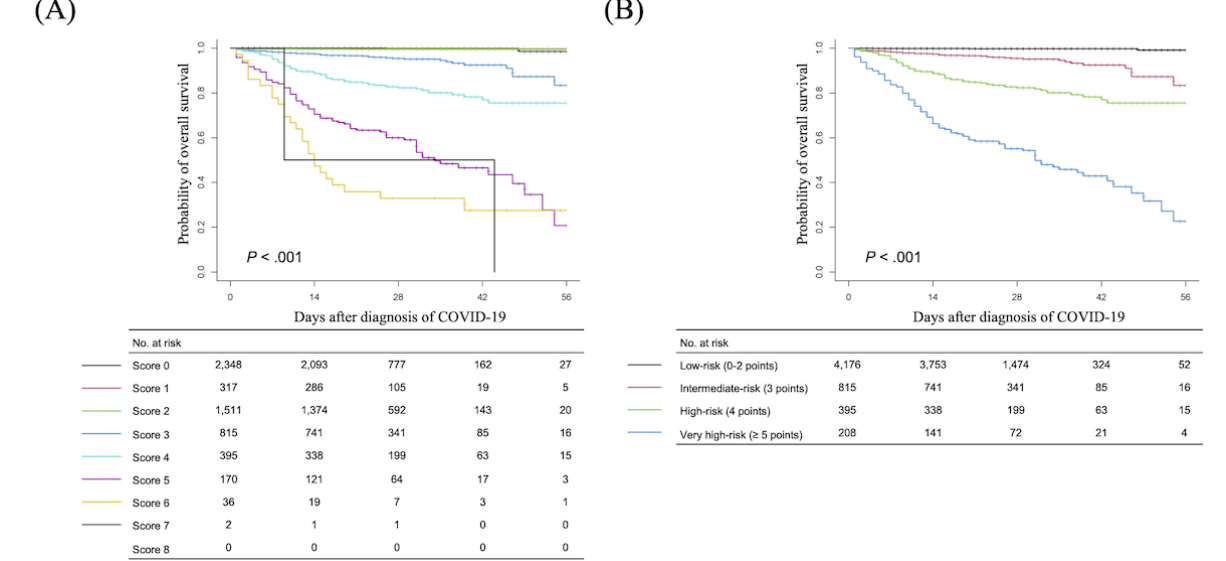
Figure 4. Probability of overall survival in patients with COVID-19 according to (A) each score and (B) the final COVID-19 prognosis score